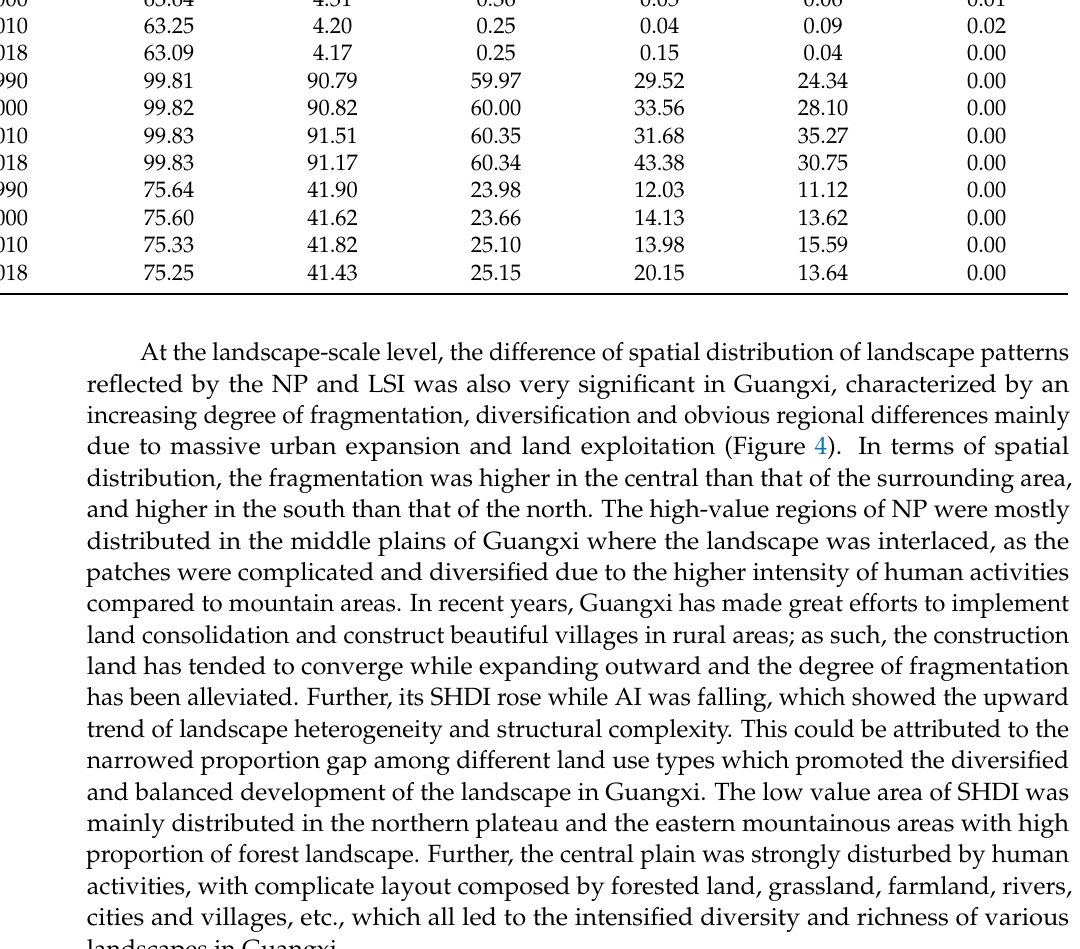
proportion of forest landscape. Further, the central plain was strongly disturbed by human activities, with complicate layout composed by forested land, grassland, farmland, rivers, cities and villages, etc., which all led to the intensified diversity and richness of various landscapes in